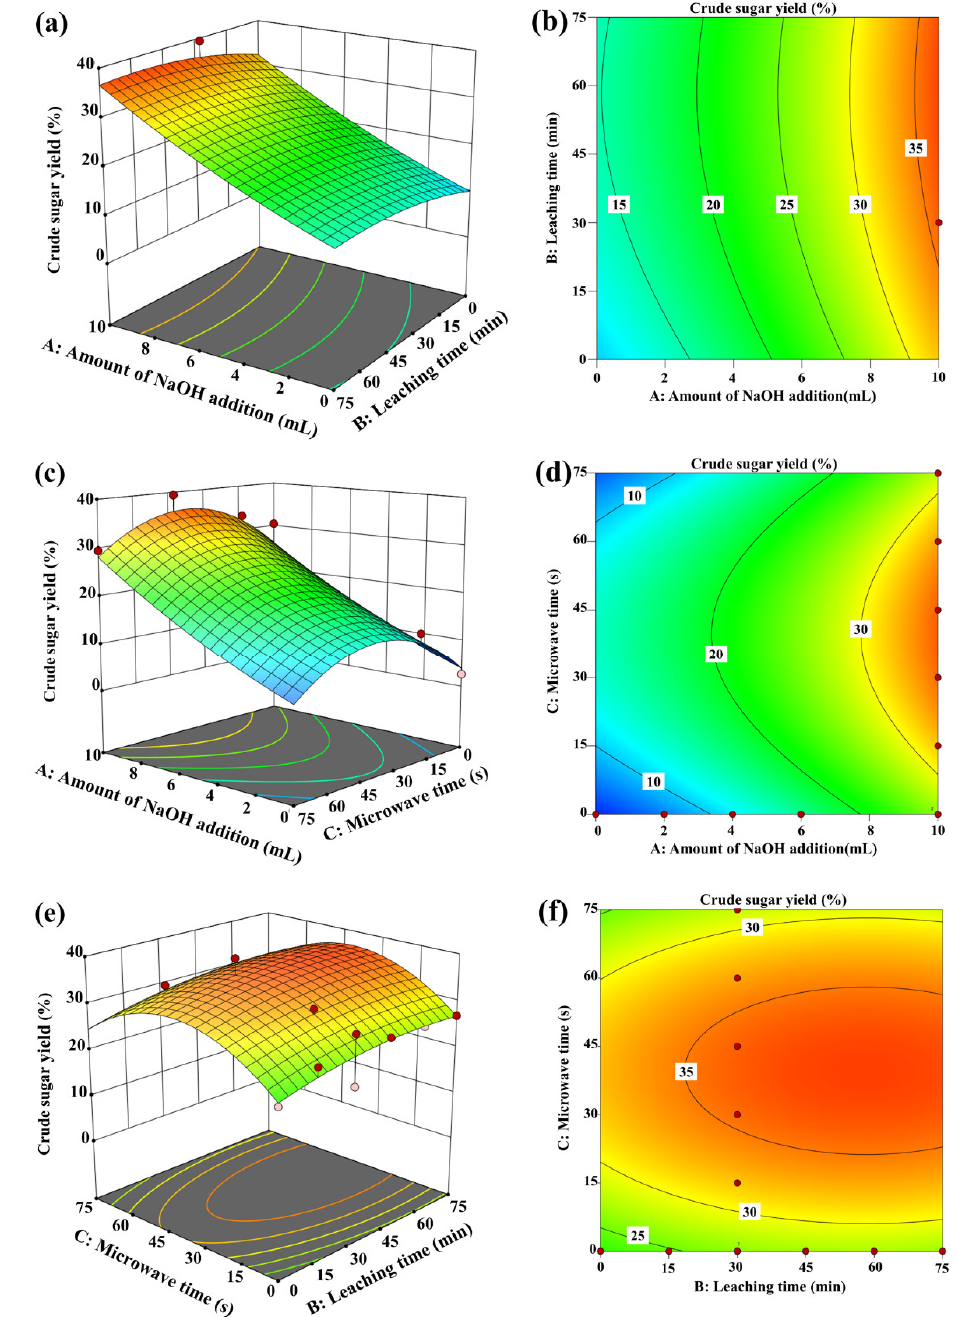
Figure 4. Response surface plots and contour plots of crude sugar yield based on the effect of leaching time and amount of NaOH addition ( a , b ), amount of NaOH addition and microwave time ( c , d ), microwave time and leaching time ( e , f ). The circles represent the crude sugar yield obtained in the experiment, which are red if they are above the predicted value and pink if they are below the predicted value.